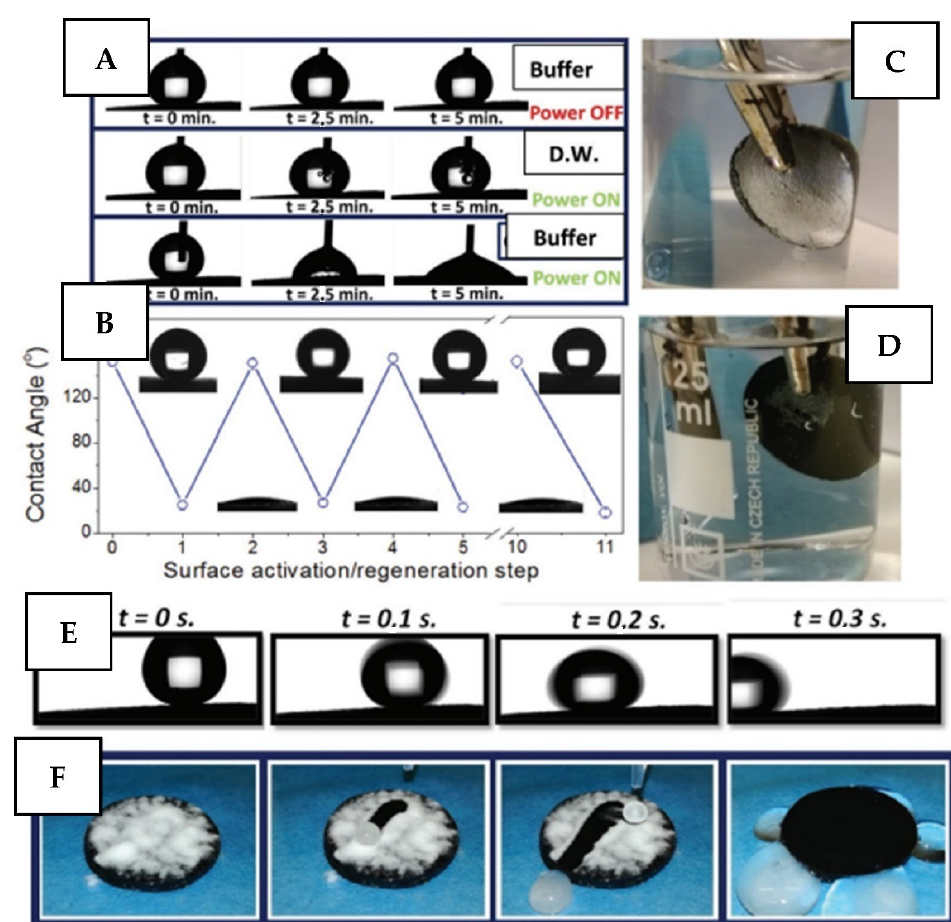
Figure 11. Advanced functionalities and electric field (EF) switchable behavior of polypyrrole functionalized silicon surface: ( A ) Time-dependent behavior of water droplets (deionized water or ions containing water) on the sample surface with and without application of EF; ( B ) repeated cycles (EF on/off) of electro-induced surface transition from a superhydrophobic state to a hydrophilic one (surface activation/regeneration); ( C , D ) photography of the samples immersed in water before and after application of EF triggering; ( E ) time-dependent water droplets slipping along the slightly tilted (5°) sample surface; ( F ) example of self-cleaning test on the pristine (or regenerated) sample surface. Reprinted with permission from ref. [142]. Copyright 2019 Wiley.